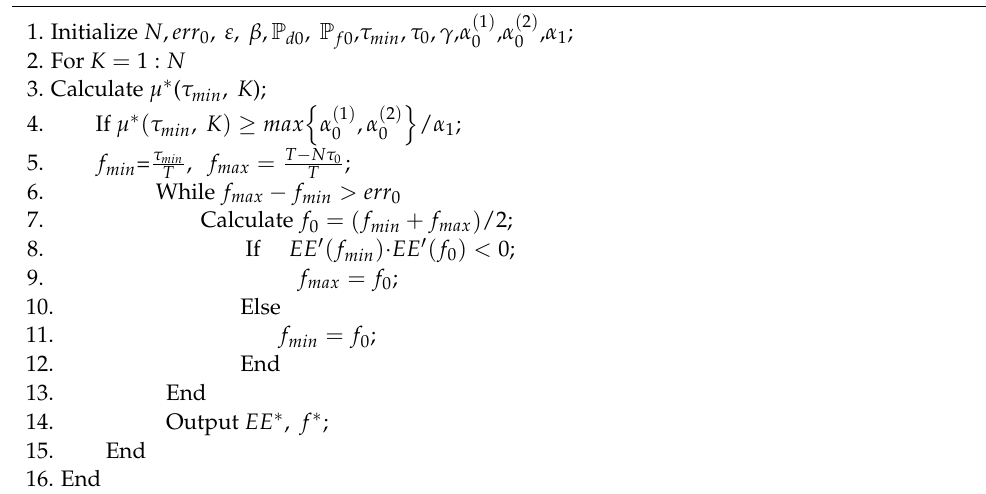
Algorithm 1. Bisection Search Algorithm for EE